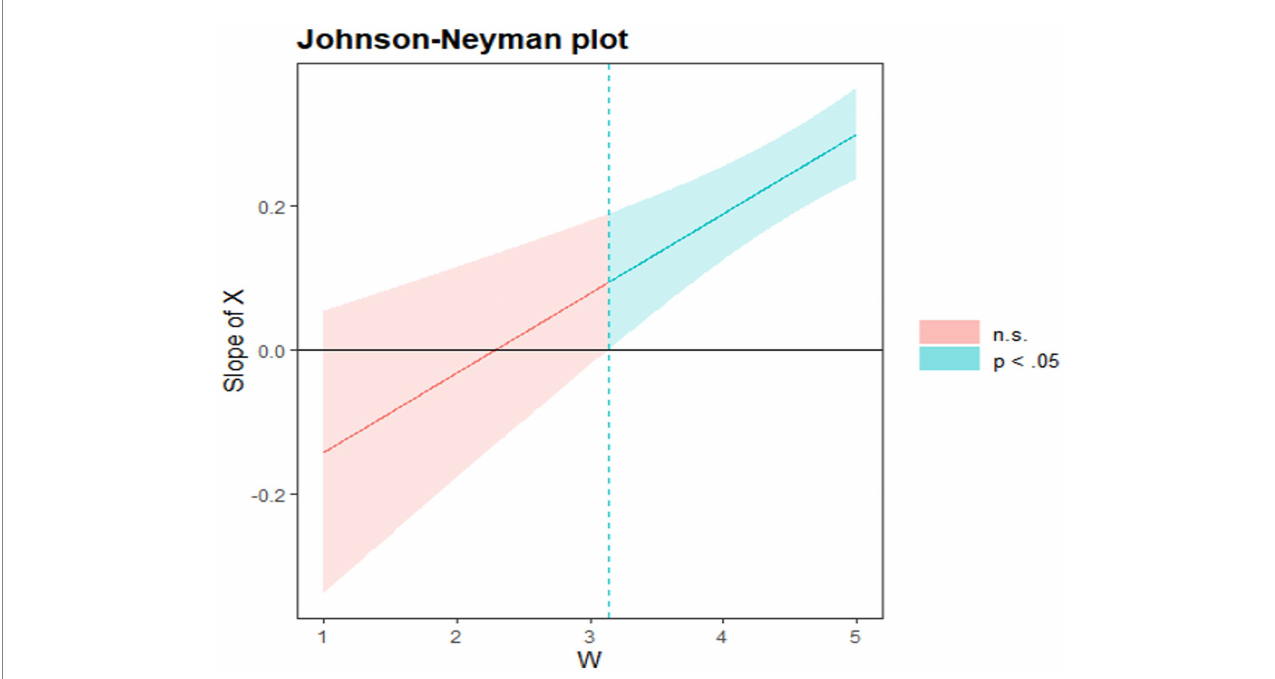
FIGURE 4 The moderating role of teacher support in the relationship between school climate and achievement motivation. X is the dependent variable school climate; W is the moderating variable teacher support.